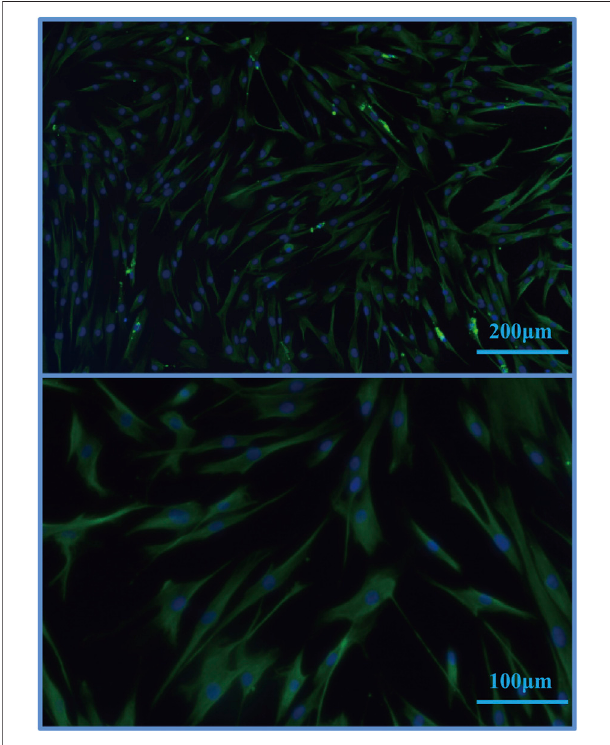
FIGURE 1 | Immuno fl uorescence identi fi cation images of